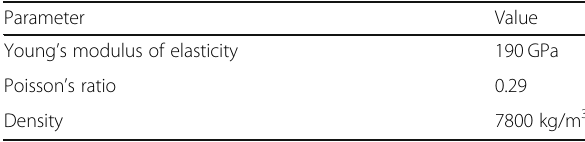
Table 1 Material properties for the static